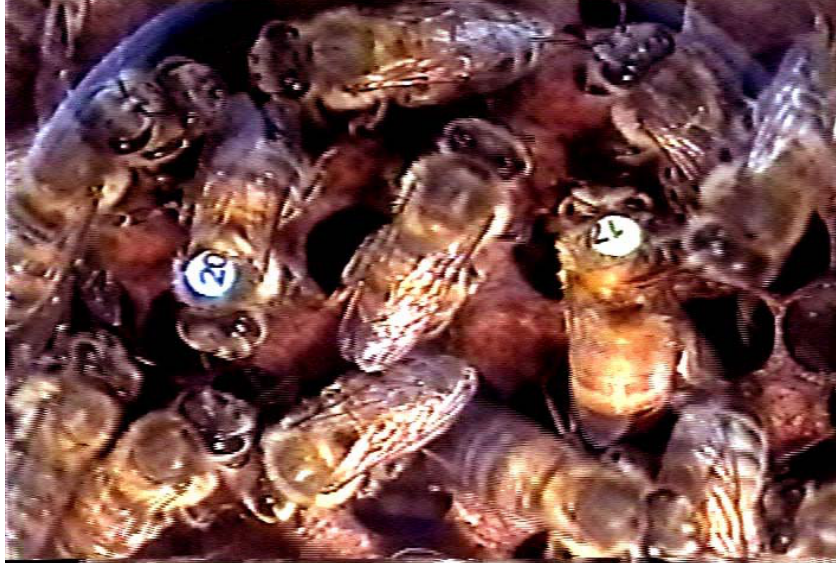
Figure 1 . Two honeybee workers marked with numbered plastic discs: the bee on the left (20) is Africanized and the other (17) is Italian ( Apis mellifera ligustica